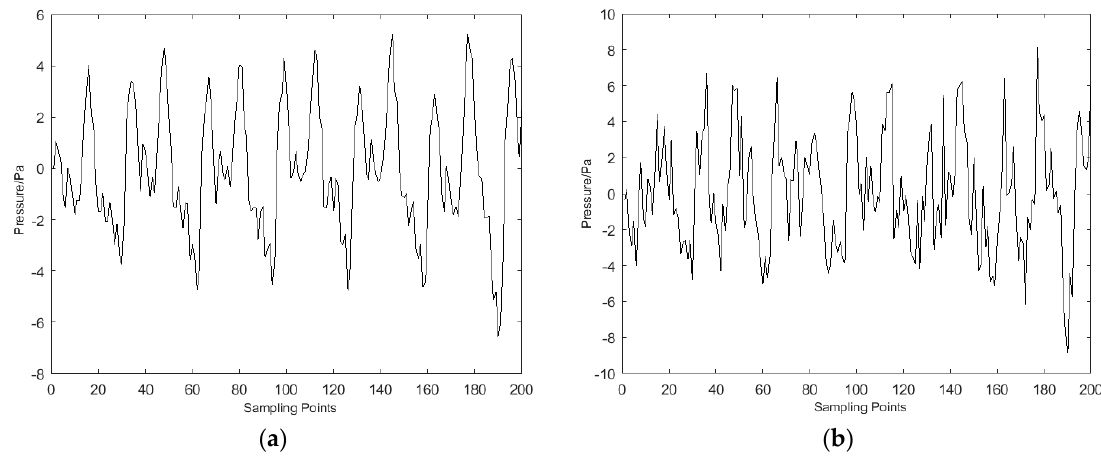
Figure 3. Pressure signal before filtering: ( a ) The original signal; ( b ) The signal after adding Gaussian white noise.